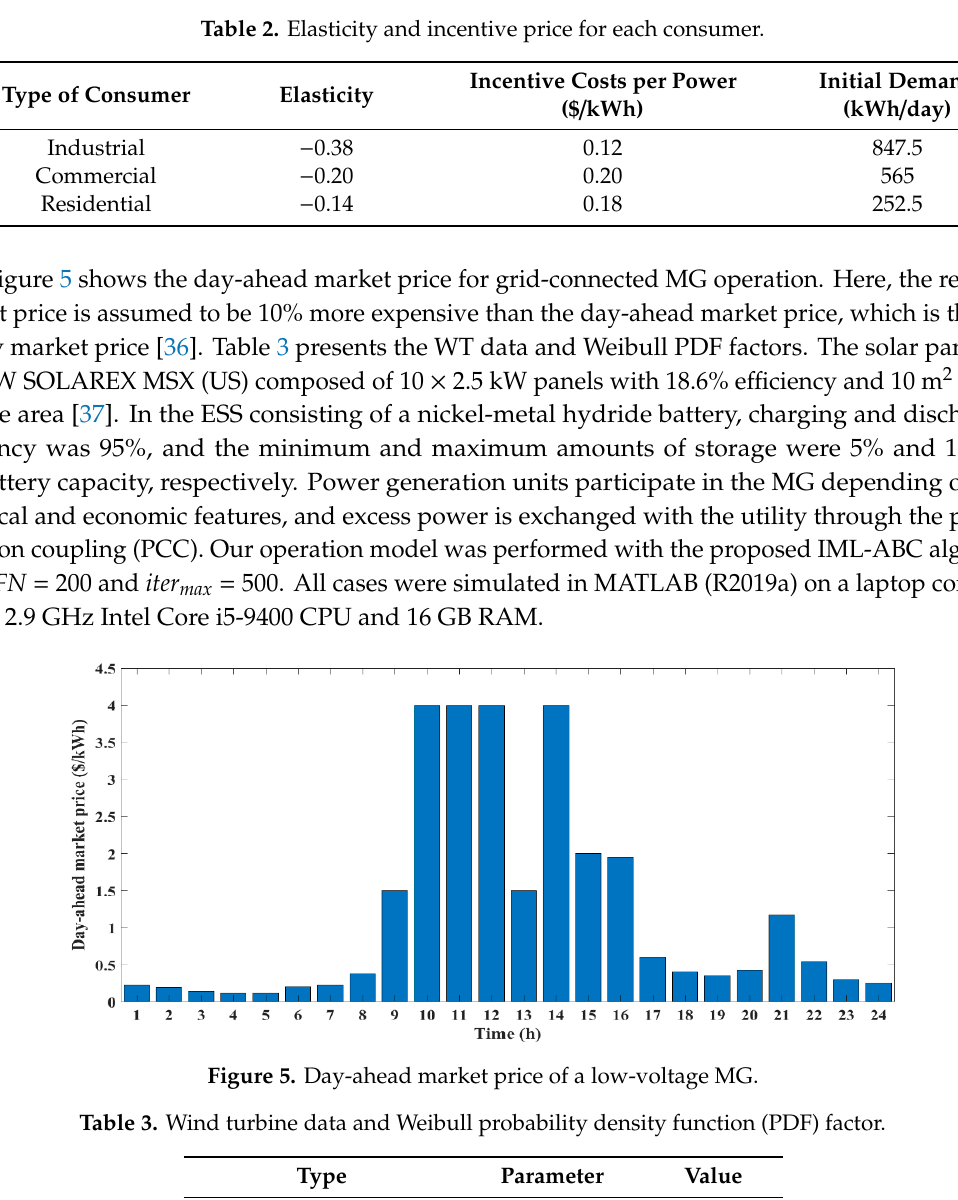
Table 2. Elasticity and incentive price for each consumer.